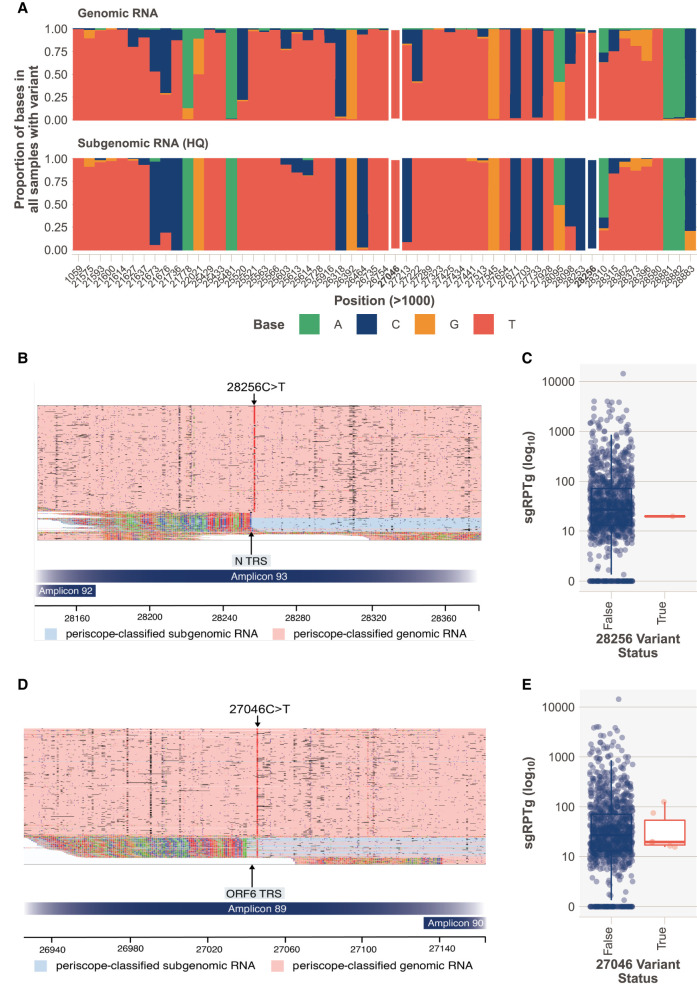
Variants in sgRNA. (A) Base frequencies at each of the variant positions called by ARTIC in each sample (multiple samples can be represented at one position), split by read class. White rectangles represent variants detailed in B and C. (B) SHEF-C0F96 has a 28,256C > T variant, of high quality that sits in the ORF N TRS sequence. This variant is not present in sgreads. (C) Normalized sgRNA expression (sgRPTg) for the N ORF in samples with the variant and without. N expression is one of the lowest in the cohort. (D) SHEF-C0C35 has 27,046C > T variant of high quality that sits in the TRS sequence. This variant is present in both gRNA and sgRNA. (E) ORF6 expression levels in samples with 27046C > T.